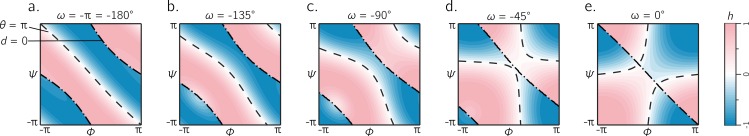
The landscape of backbone chirality as a function of amide dihedral angle ω.As ω is changed, the features of the landscape smoothly transform from the landscapes of ω =  ± π to ω = 0. For all values of ω, it is evident that the naïve view of chirality (Fig. 1D) is wrong: at least four distinct regions of chirality (separated by boundaries d = 0 and θ = π) are evident in each scenario. Although only five snapshots (values of ω) are shown, all integer values of ω were tested, which corroborates the fact that the naïve view of backbone handedness (Fig. 1D) is universally incorrect.